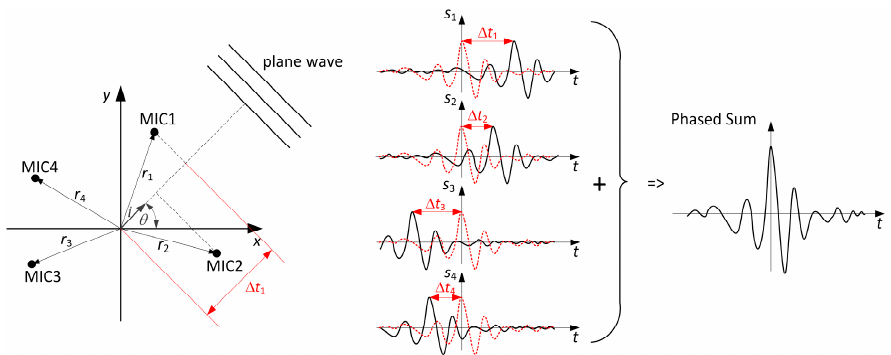
Figure 1. The conventional delay-and-sum algorithm in the time